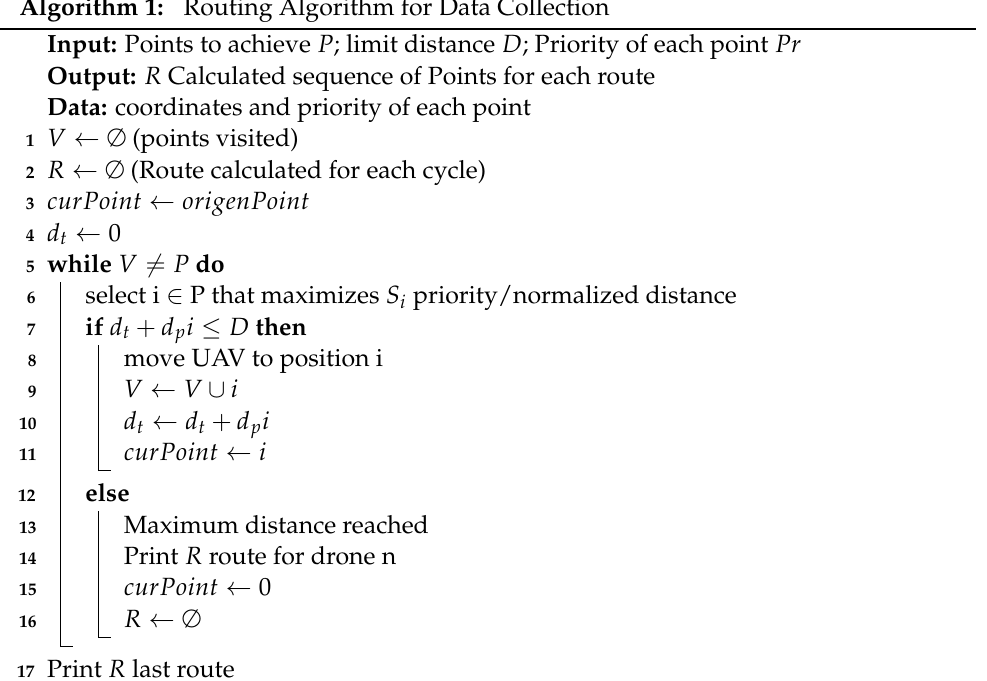
Algorithm 1: Routing Algorithm for Data